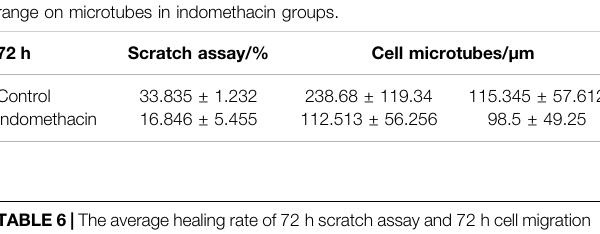
TABLE 6 | The average healing rate of 72 h scratch assay and 72 h cell migration range on microtubes in nimesulide groups. 72 h Scratch